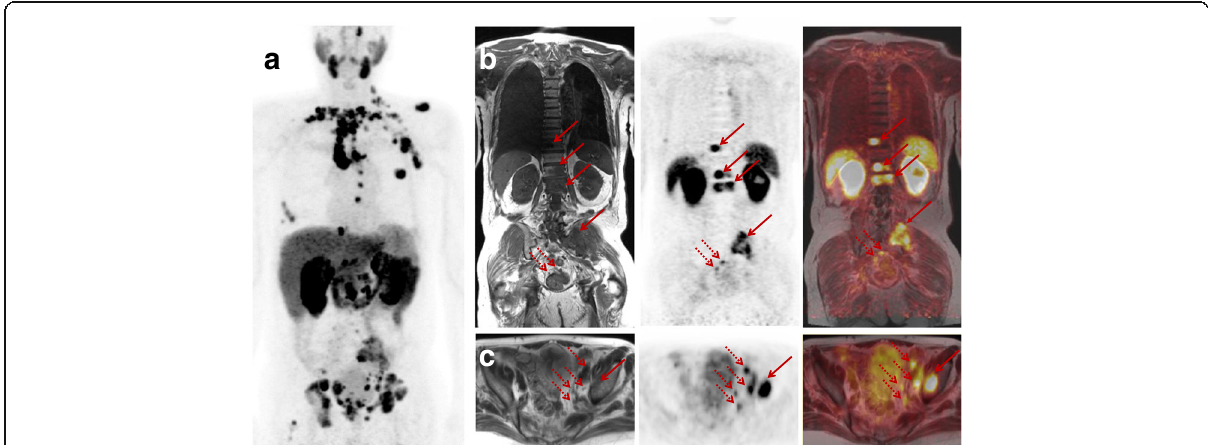
Fig. 6 PET/MR imaging in a mCRPC patient (PSA 392 ng/ml) using EuE-k- 18 F-FBOA (1) demonstrates intensive PSMA-ligand uptake in multiple bone (arrows) and tiny subcentimeter lymph node (dotted arrows) metastases. Maximum intensity projection ( a ) shows distribution of disease. Sets b and c shows coronal and axial MR (T1 and T2 haste), PET and fused images with arrows and dotted arrows representing bone and lymph node metastases,